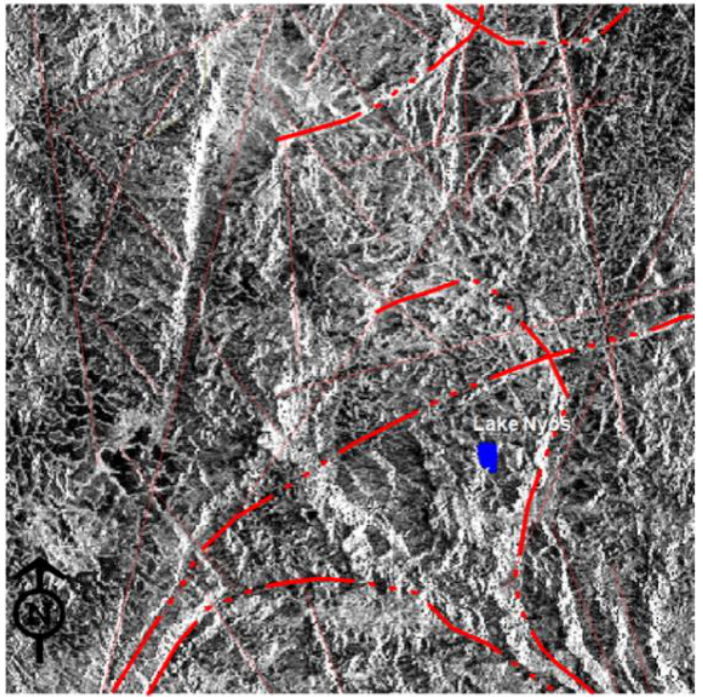
Figure 8. Geologic features in ERS1radar image (image obtained from ESA). One can identify on this image the main lineaments, fault directions and structures around Lake Nyos.